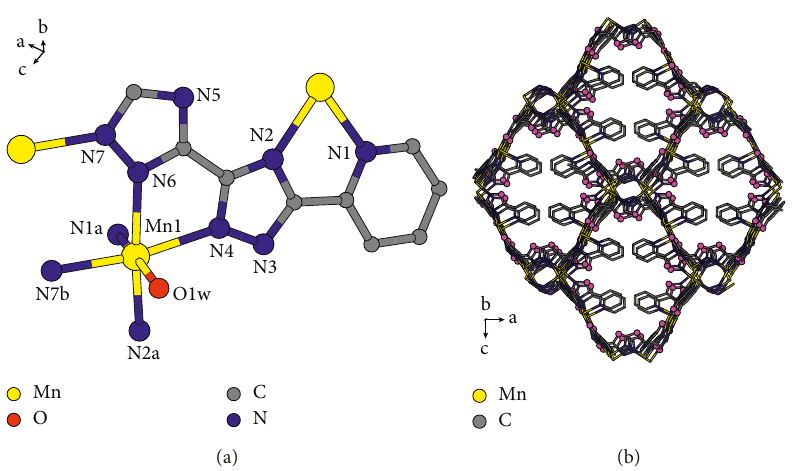
Figure 1: (a) Coordination environment of Mn (II) in compound 1; (b) the 1D channel of compound 1 (the pink atoms stand for uncoordinated N